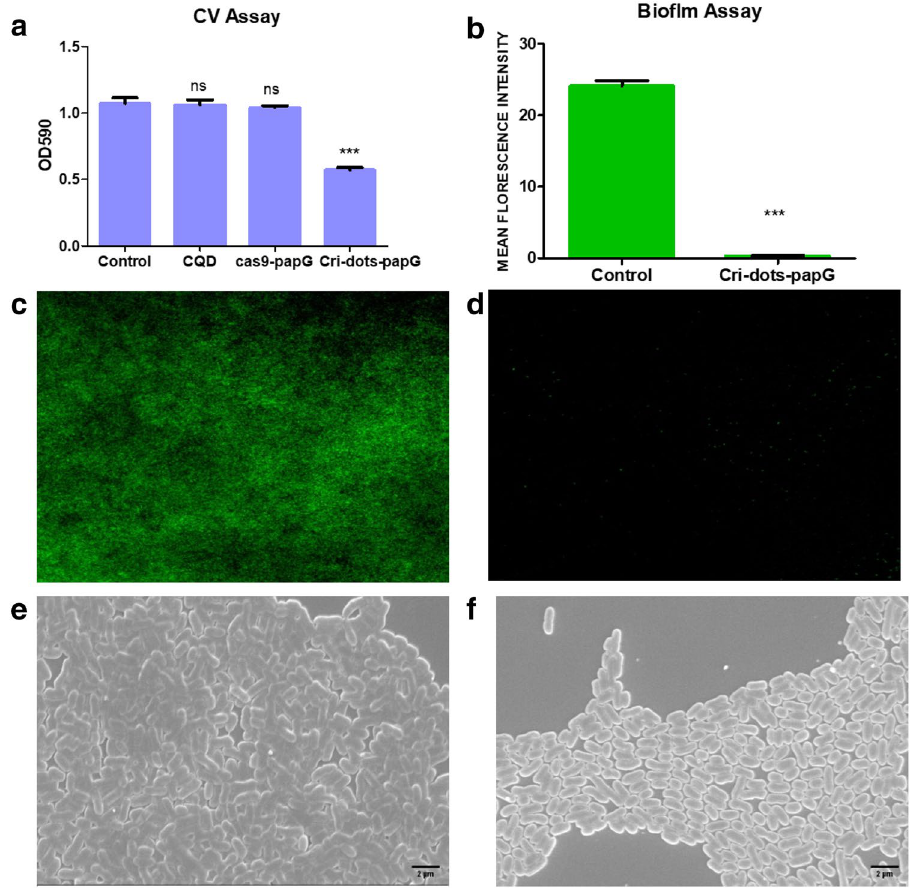
Figure 5. Cri-dots-papG targeting CFT073 reduces its biofilm forming ability. ( a ) Quantification of biofilm formation was assessed in control, only CQD, cas9-papG and Cri-dots-papG by crystal violet assay. The data represents an average of triplicate experiments as mean ± SD (1.072 ± 0.043, control vs 0.570 ± 0.019, Cri-dots- papG). (*** p < 0.001, t test, 2 sided). Biofilm formation of only CQDS and cas9-papG showed no significant difference from control. Biofilm assay formation measured using florescence microscopy in ( c ) control and ( d ) Cri-dots-papG.Green fluorescence indicates Syto9 stained live bacteria. ( b ) Quantitative analysis of florescence images using imageJ and Graphpad prism5 (24.125 ± 1.2996, control vs 0.310 ± 0.1504, Cri-dots-papG). Scanning electron micrographs of ( e ) Control and (f)